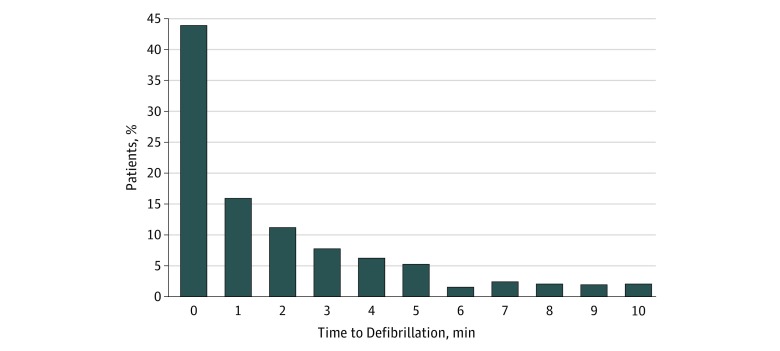
Distribution of Time to First Defibrillation AttemptProportion of study participants per 1 minute elapsed between loss of pulse and time
to first defibrillation attempt.